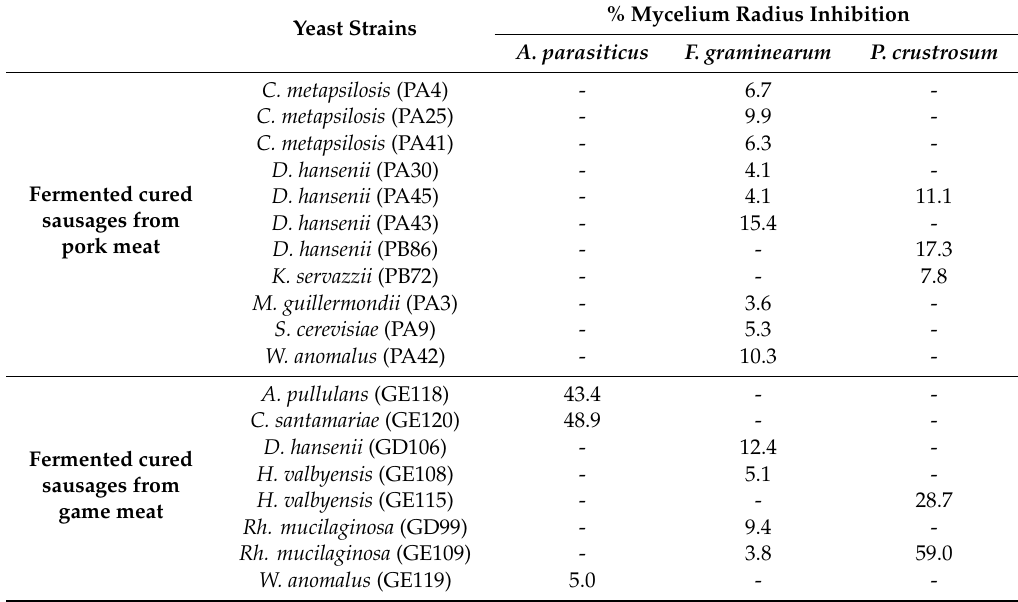
Yeast strains biocontrol activity: Inhibition % of the mycelium growth radius of mycotoxigenic